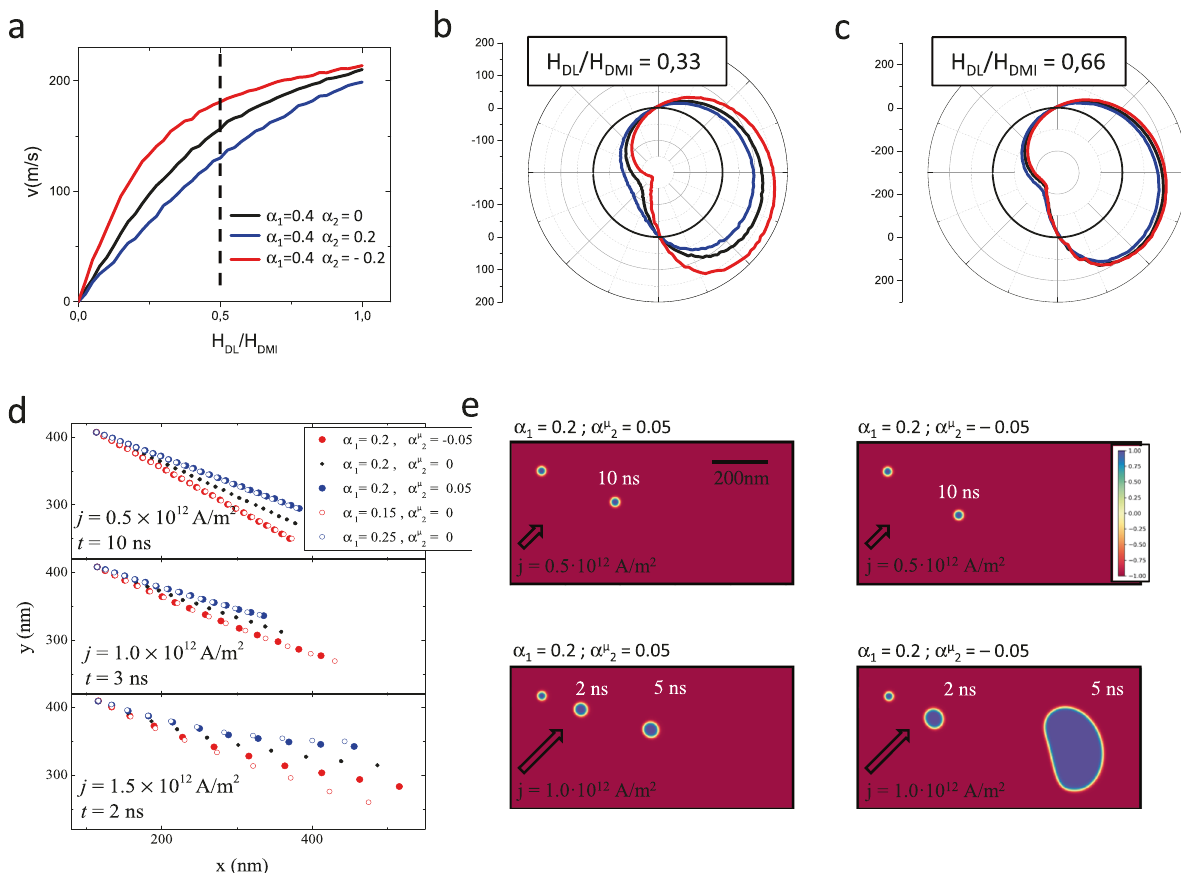
Fig. 5 Modelling of the SK distortion in presence of the chiral damping. a CIDM plotted as a function of the ratio of H DL /H DMI . The dotted line approximately separates the linear variation regime from the plateau. Here, H DMI = 0.2 T and H DL = 2·H FL . The values chosen for these simulations are close to the optimal values and very importantly, they are realistic (typical for Pt/Co/AlO x systems). b angular dependence of the velocity in the linear regime c . angular dependence of the velocity in the saturation regime. (black: α 1 = 0.4; blue: α 1 = 0.4, α 2 = 0.2; red: α 1 = 0.4, α 2 = − 0.2) d . Skyrmion position as a function of time for different current and damping values. e Superposed images of the out-of-plane component of the micromagnetic structure at different moments of time during the simulation. On each image, the SK on the left corresponds to the initial state. At low current density (top row) the SK structure remains intact during the displacement. Chiral damping only in fl uences the trajectory. At larger currents, at fi rst, the SK undergoes a slight distortion, which in the case of α 1 = 0.2 and α µ 2 = − 0.05, leads to its instability and the SK explodes. Here the electric current is applied at 45° with respect to the stripe major Numerical model . The best agreement between the ensemble of experiments and the q- ϕ model was obtained with the following set of parameters: DW width,